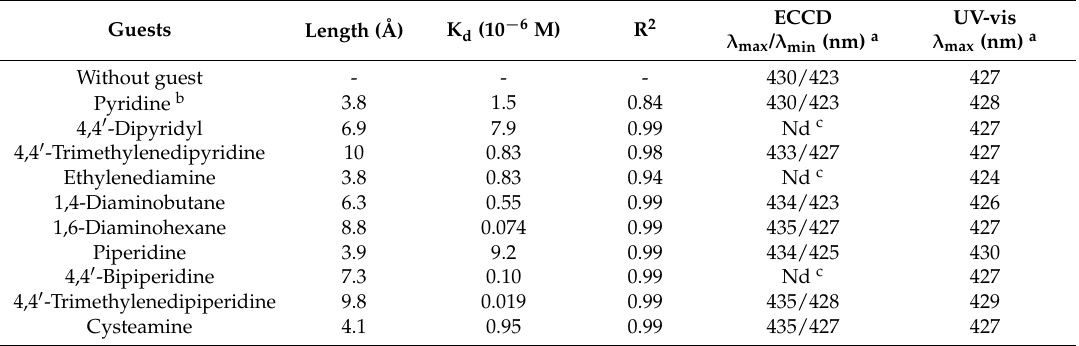
Table 1. Results of spectroscopic titration for binding constant determination (complexation of 2 with guest